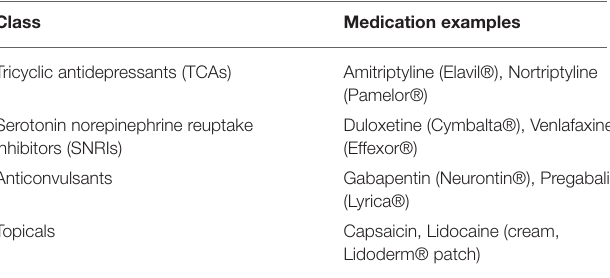
TABLE 1 | Examples of neuropathic pain